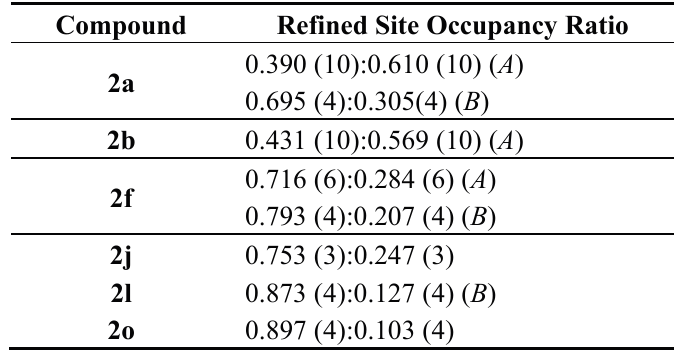
Table 1. Refined site occupancy ratio for disordered compounds.